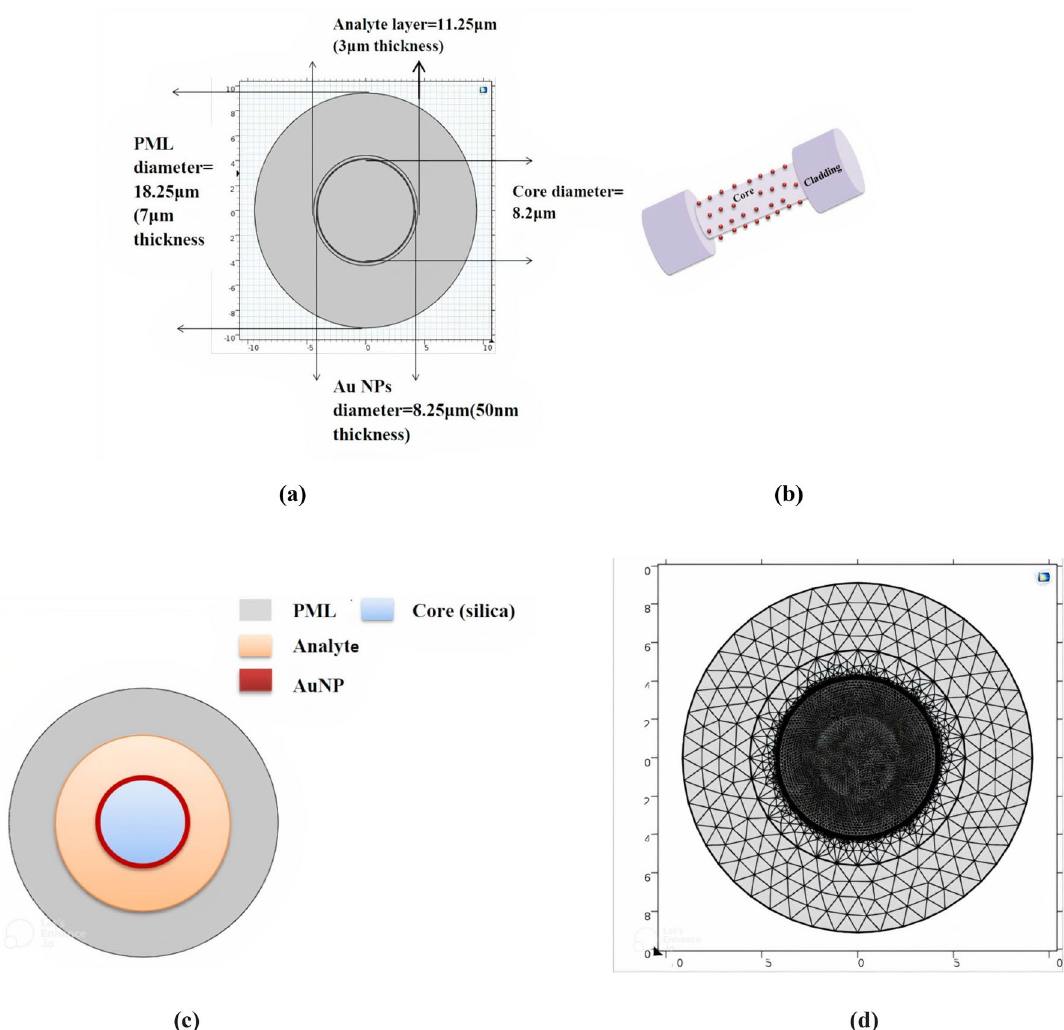
Figure 1. Presents ( a ) the cross section and the dimension of the sensor final structure, ( b ) the geometry of the unclad fiber deposited with Au NPs, ( c ) the core, Au NPs layer, analytic layer, and PML materials, and ( d ) the mesh of the